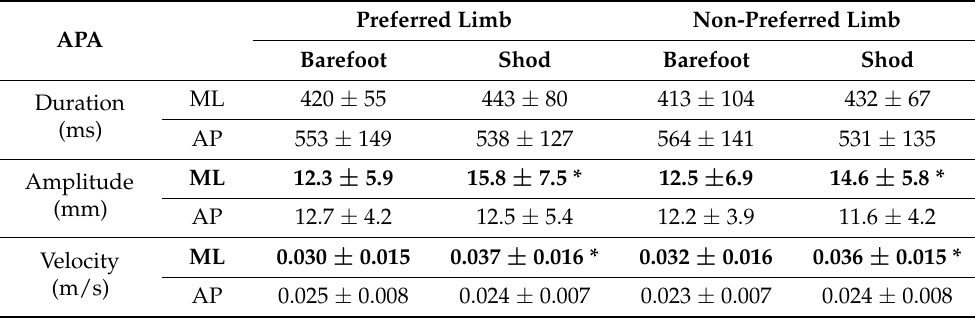
Table 1. APA parameters values (mean ± std. dev.) for the participants, divided between experi- mental conditions. Main effects for Condition (Barefoot vs. Shod; p < 0.05) are indicated in bold. * indicates difference with respect to the barefoot condition.